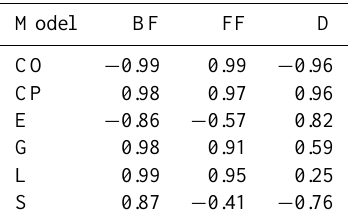
Table 5. Correlation coefficients between CC and COD changes from PD and each